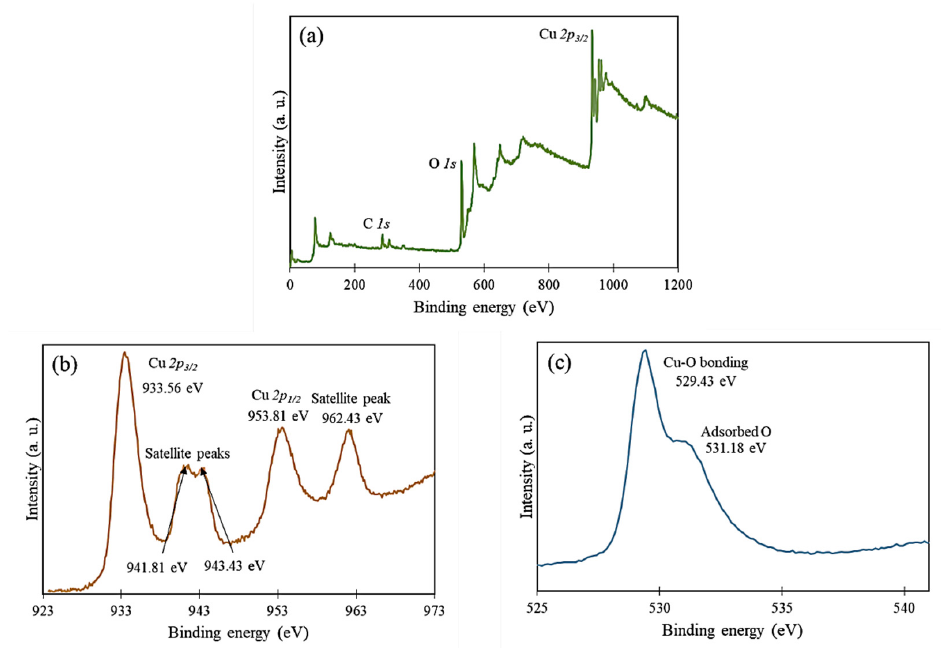
Figure 6. XPS measurement of ( a ) mangosteen leaf extract-mediated CuO NPs, ( b ) high-resolution Cu 2p peaks and ( c ) high-resolution O 1s peaks.